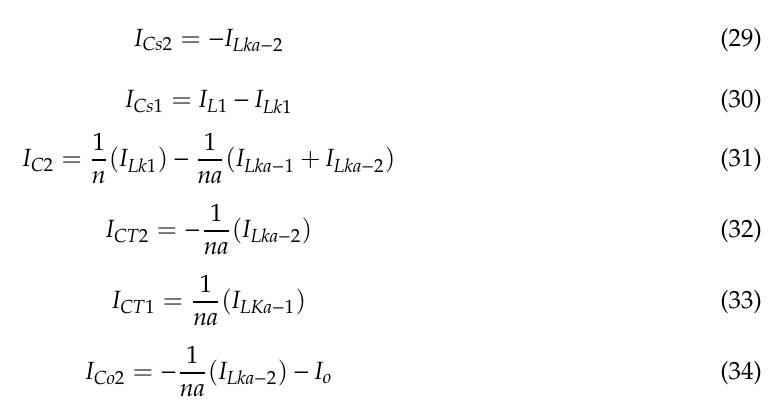
Figure 5. Fourth switching state.